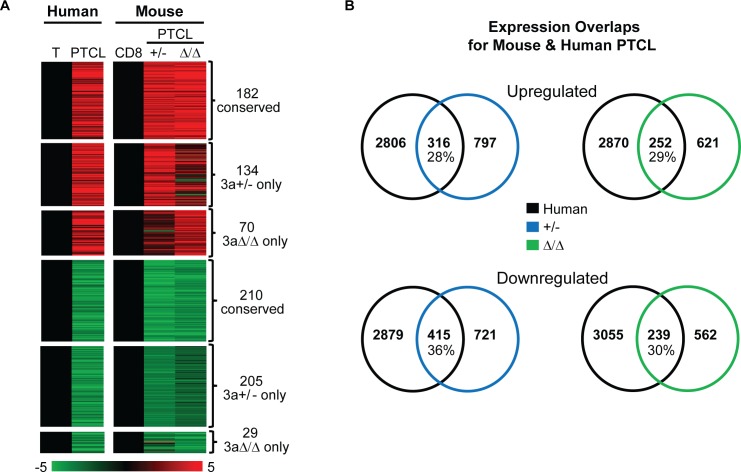
Gene expression changes are partially conserved between mouse and human PTCL.(A) Heat maps derived from global expression profiling for genes differentially expressed in both human PTCL (PTCL) relative to normal tonsil T cells (T) and in Dnmt3a+/- PTCL (+/-) and/or Dnmt3aΔ/Δ PTCL (Δ/Δ) relative to normal Dnmt3a+/+ CD8+ cells. 182 genes were commonly overexpressed in human PTCL, Dnmt3a+/- PTCL, and Dnmt3aΔ/Δ PTCL, while 210 genes were commonly underexpressed in all three tumor types. 134 overexpressed and 205 underexpressed genes were specific to human PTCL and Dnmt3a+/- PTCL, whereas 70 overexpressed and 29 underexpressed genes were only observed in human PTCL and Dnmt3aΔ/Δ PTCL. For microarray data (human samples), genes with a fold change >1.5 and a P-value <0.05 were considered significant. For RNA-seq data (mouse samples), genes with a fold change >2 and a p-value <0.05 were considered significant. A color bar displays fold change in gene expression with overexpressed shown in red and underexpressed in green. (B) Venn diagrams showing overlaps in gene expression between human PTCL (black) and mouse Dnmt3a+/- PTCL (blue) and Dnmt3aΔ/Δ PTCL (green), as determined in panel A of the figure.